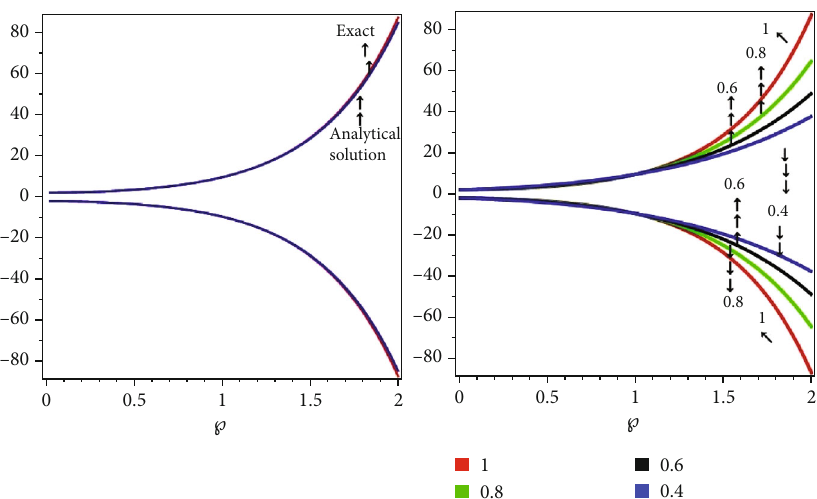
Figure 2: The fi rst graph depicts a two-dimensional fuzzy upper and bottom branch graph of an analytic series result, while the second depicts various fractional of ρ